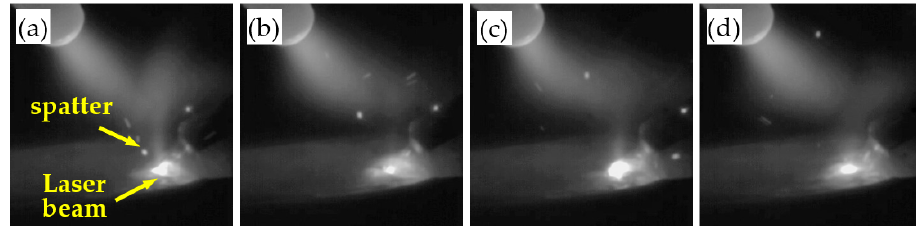
Figure 7. Laser–TIG morphology with different times when the current is 50 A: ( a ) t = 1 ms; ( b ) t = 2 ms; ( c ) t = 3 ms; ( d ) t = 4 ms.